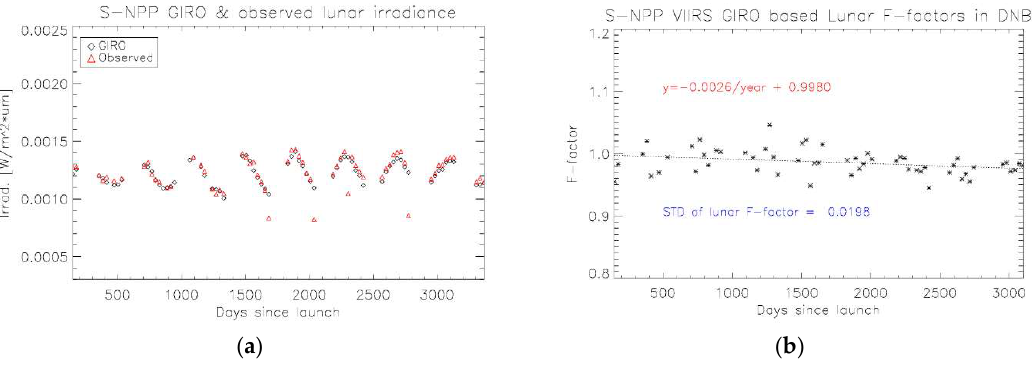
Figure 11. Lunar observed and GIRO irradiances ( a ) and the corresponding lunar F-factors ( b ).